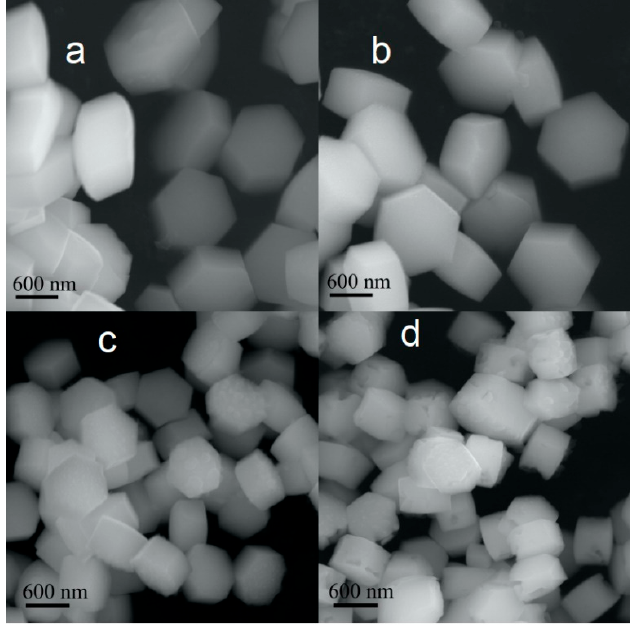
Figure 2. SEM images of the samples: ( a ) β -NaYF 4 : 20% Yb, 1% Tm, ( b ) β -NaYF 4 : 20% Yb, 1% Er, ( c ) β -NaYF 4 : 20% Yb, 1% Tm, 5% Gd, and ( d ) β -NaYF 4 : 20% Yb, 1% Er, 5% Gd. All the samples were synthesized with the same reaction time (24 h).